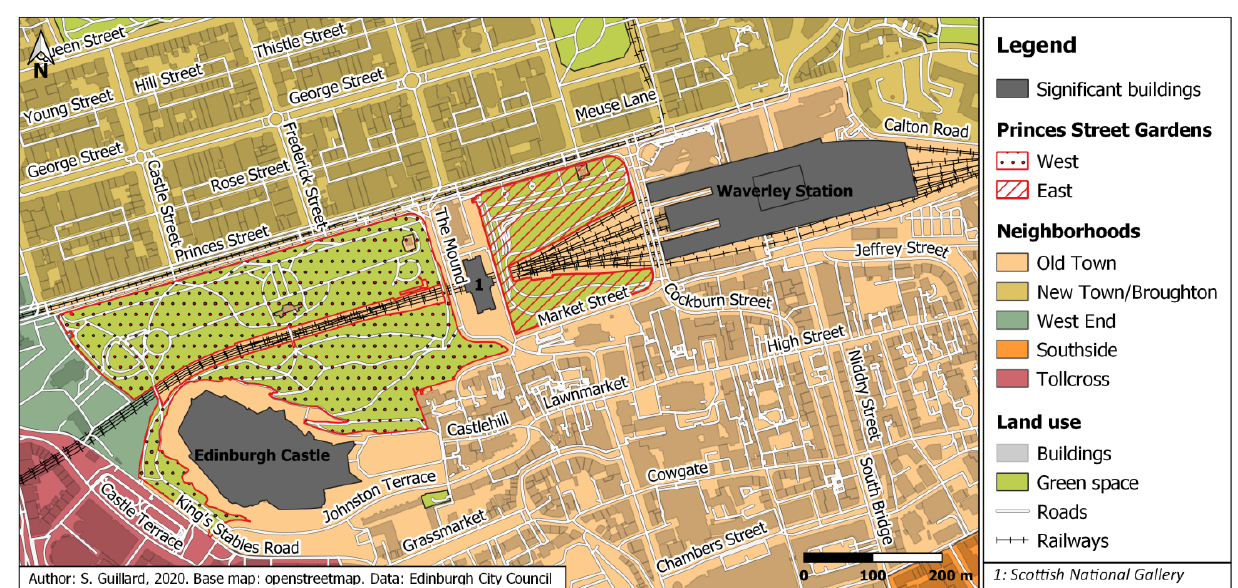
Figure 1. Map of Princes Street Gardens and surrounding areas. Source: Severin Guillard. Brandwatch Platform. Our initial data collection gath- ered several thousand tweets. Further cleansing of the